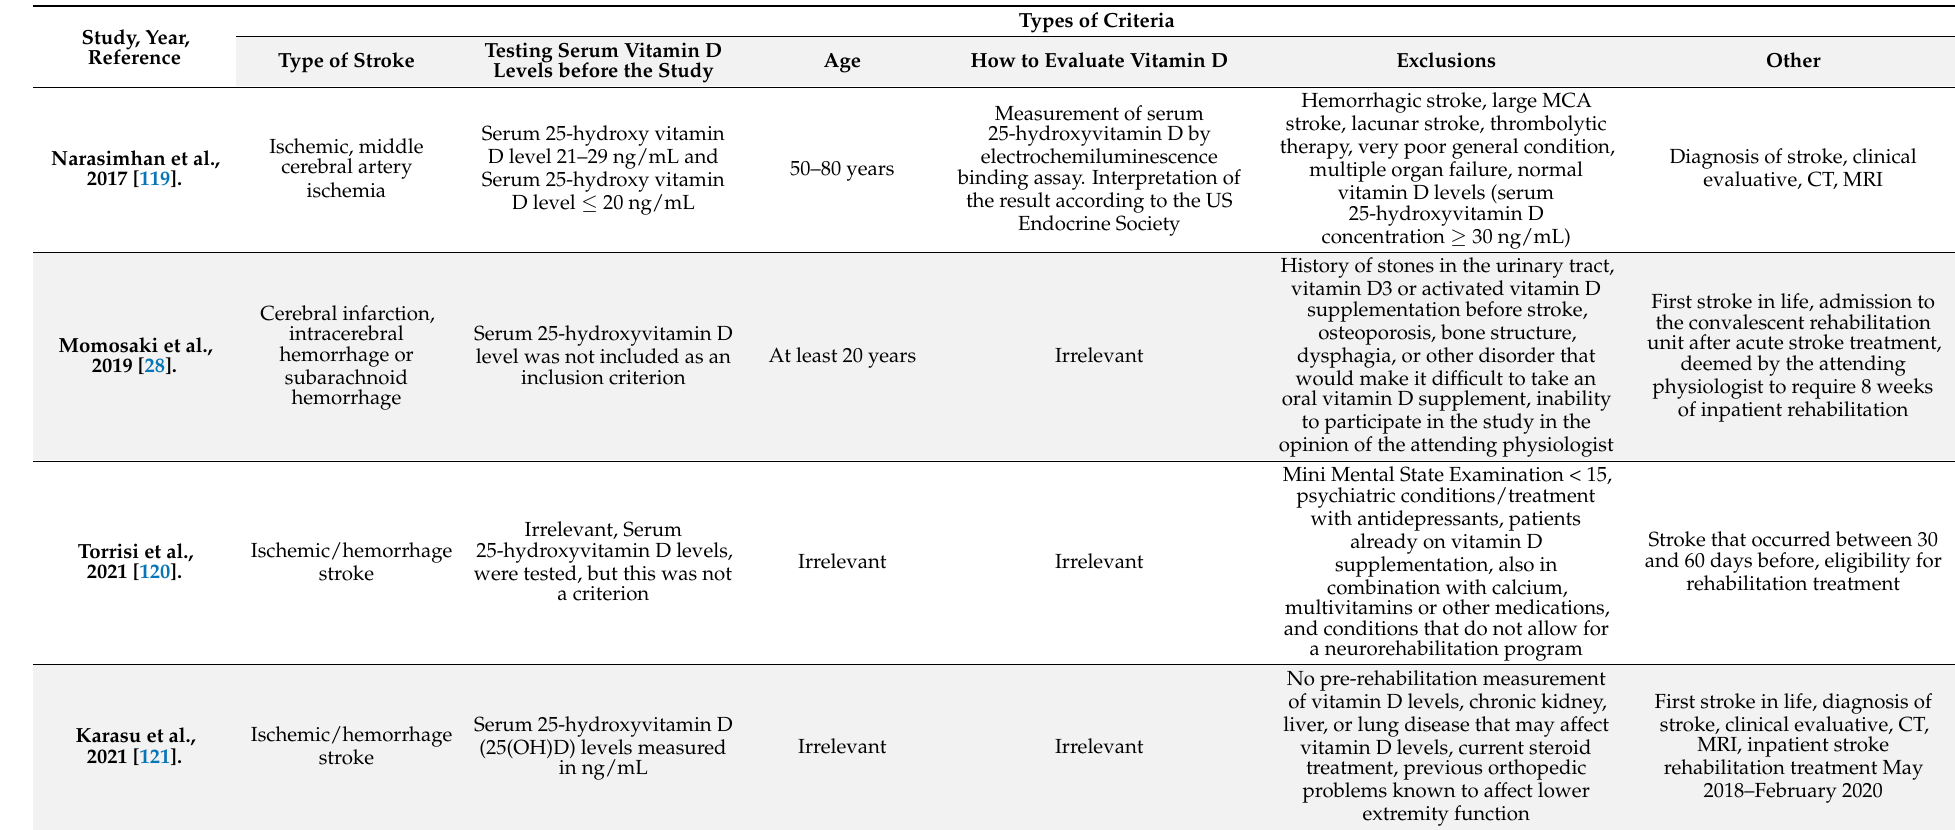
Table 1. Criteria for study entry for different